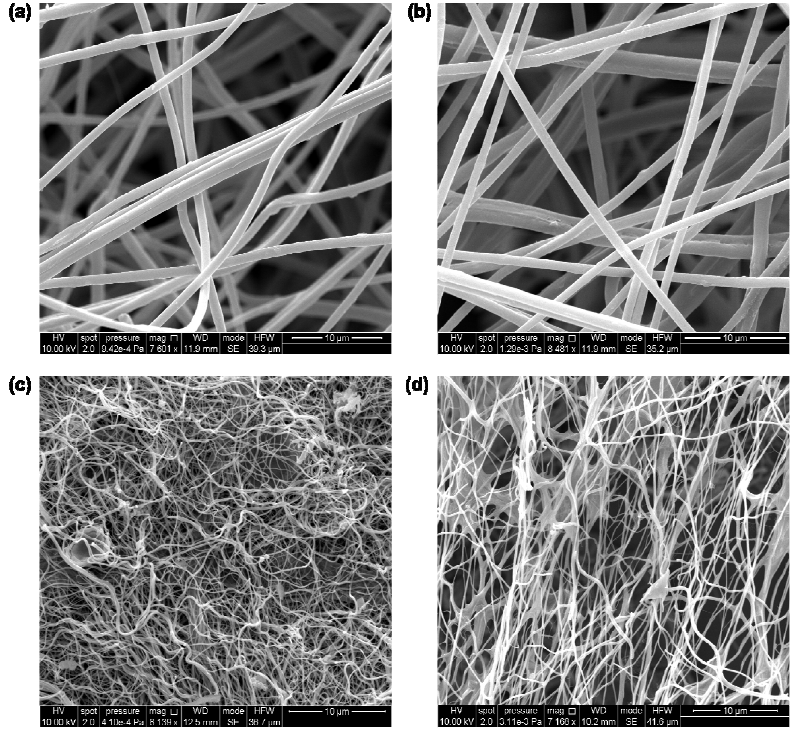
Figure 1. SEM for NiO nanofibers: ( a , b ) polyactonitrile (PAN) Ni(AcAc) ( c ) NiO nanofibers after calcinations; ( d ) NiO nanofibers on fluorine doped tin oxide (FTO) after